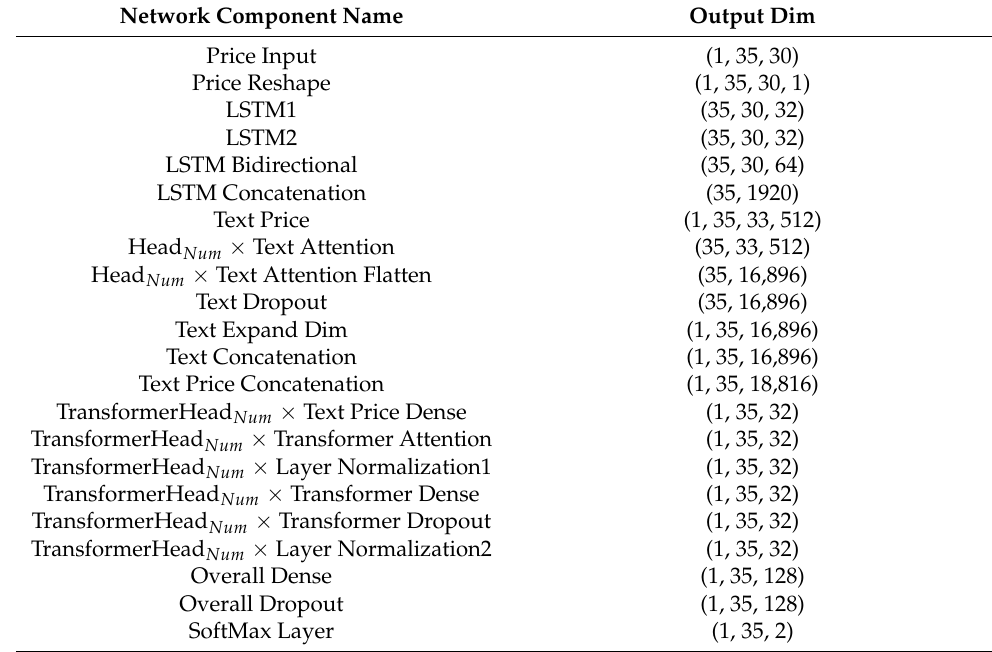
Table A1. Detailed network